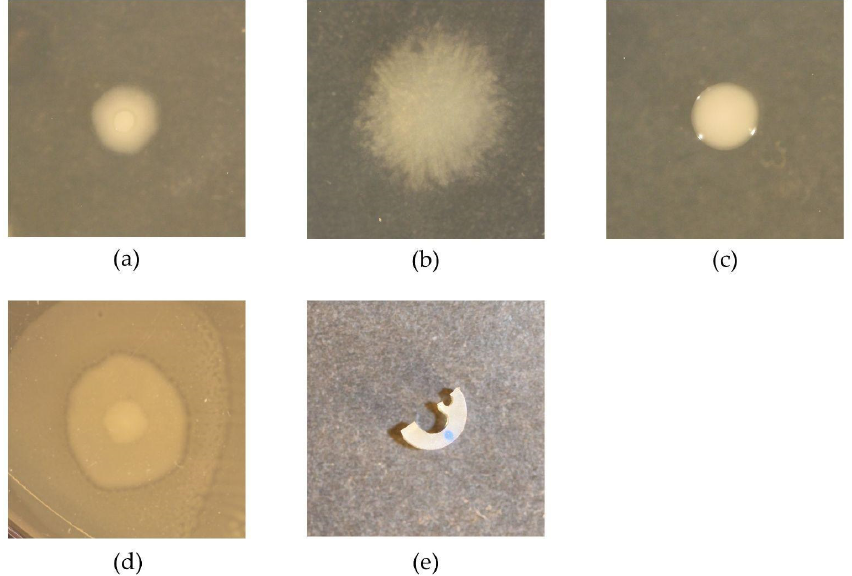
Figure 1. Illustration of pathogen colonies ( a – d ) and catheter piece ( e ). Colonies of E. coli ( a ), P. aeruginosa ( b ), K. oxytoca ( c ) and P. mirabilis ( d ) were acquired on an LB agar plate after overnight growth at 37 °C. Panel ( e ) shows a catheter piece for biofilm growth, manually cut from the shaft of a silicone Foley catheter (Biomodics ApS).